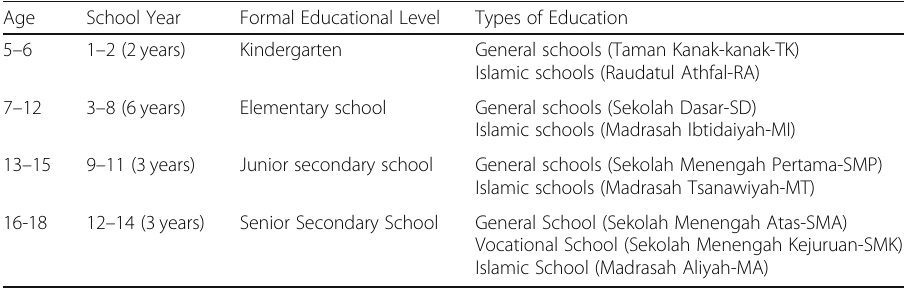
Table 1 An overview of the Indonesian K-12 education system